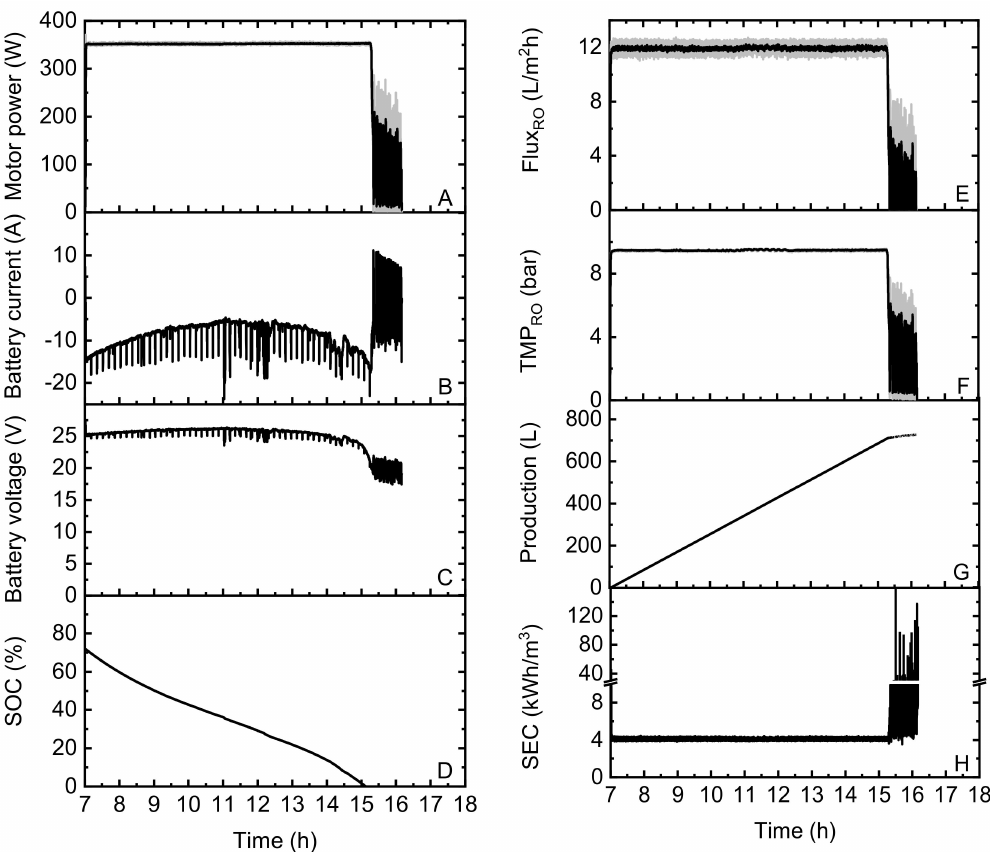
Figure A2. The performance of the PV-membrane system on the “partly cloudy day” equipped with batteries at 70% SOC, indicating ( A ) the motor power, ( B ) battery current, ( C ) battery voltage, ( D ) SOC, ( E ) RO flux, ( F ) TMP RO , ( G ) production and ( H ) SEC. Note that the black curves on graphs ( A ), ( E ) and ( F ) are the moving average values of 10